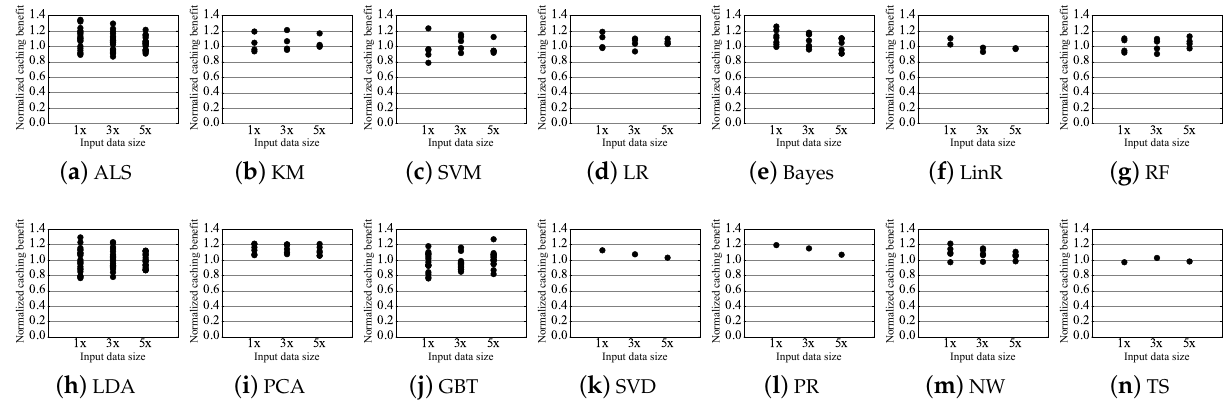
Figure 6. Predicted caching benefit normalized to actual caching benefit from the cluster measured on three sizes of input